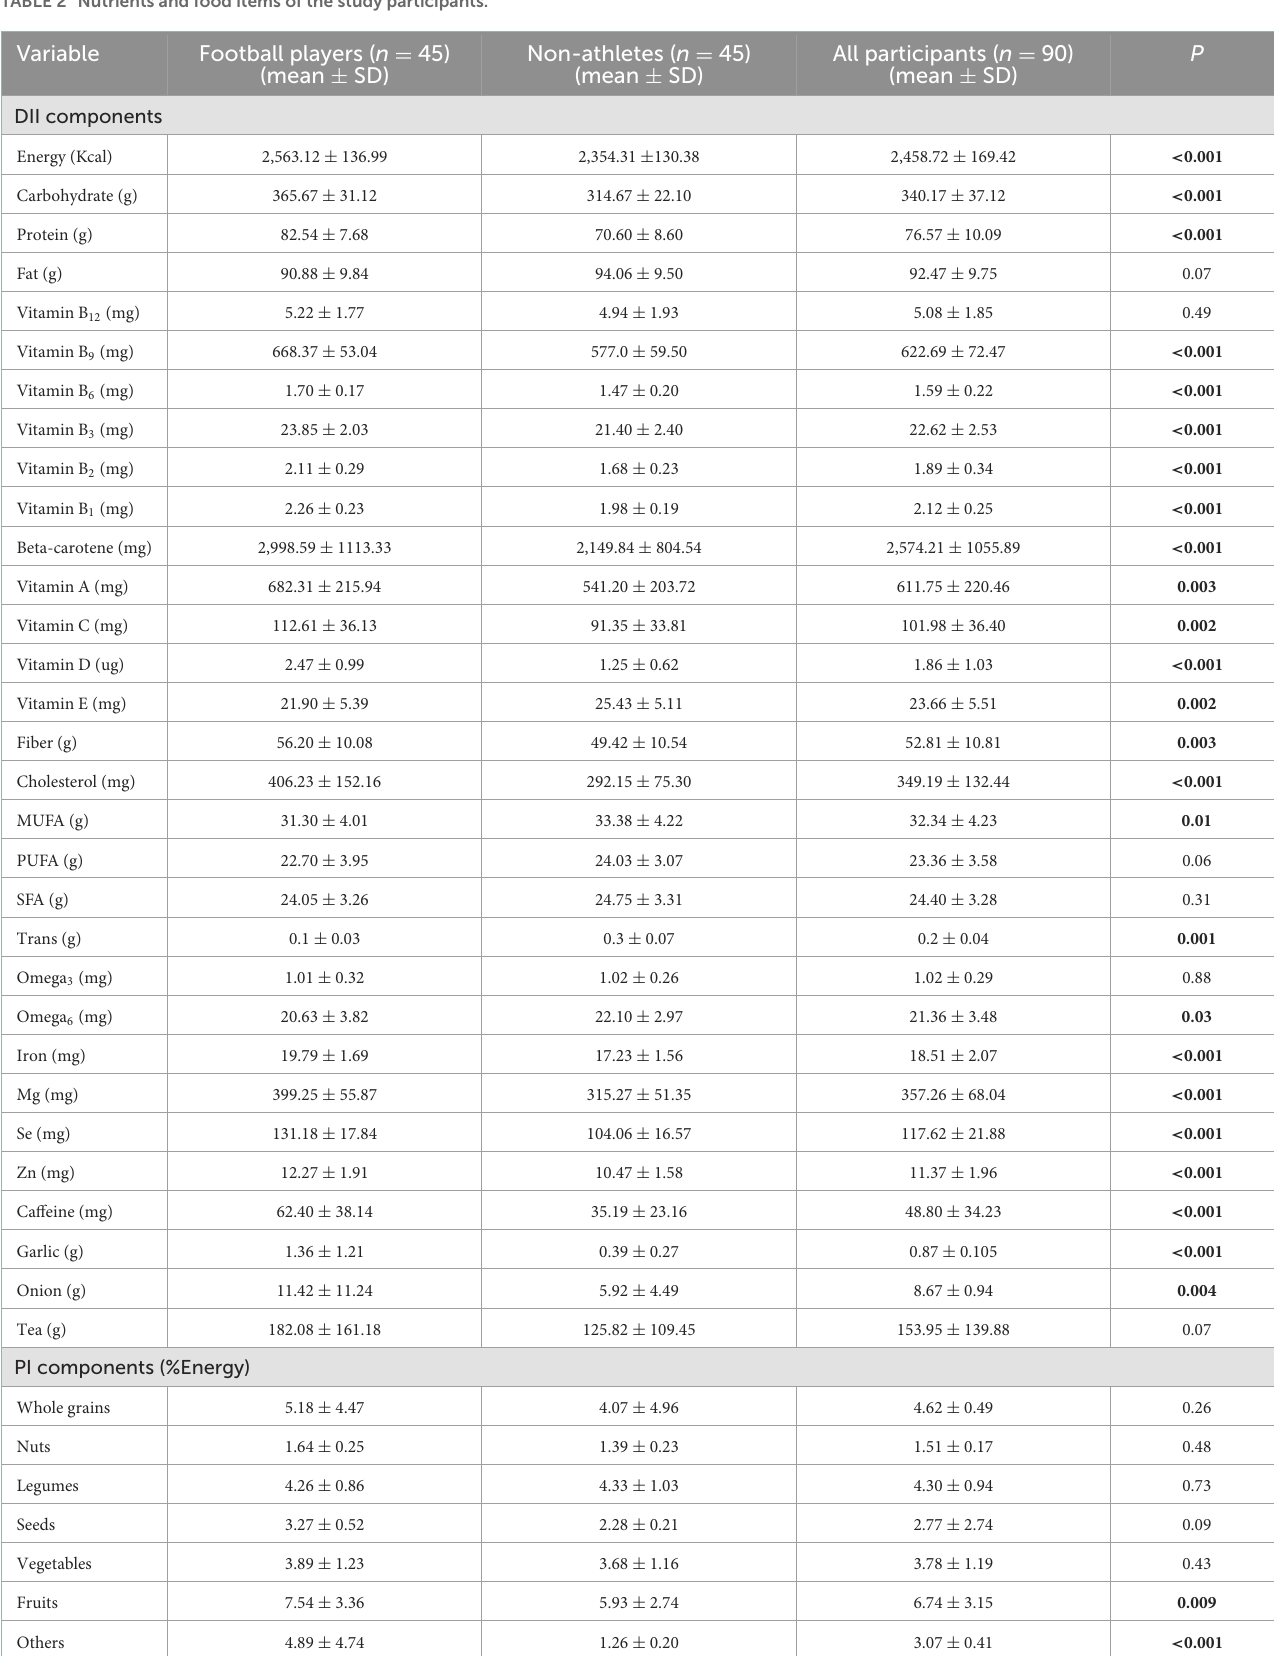
TABLE 2 Nutrients and food items of the study